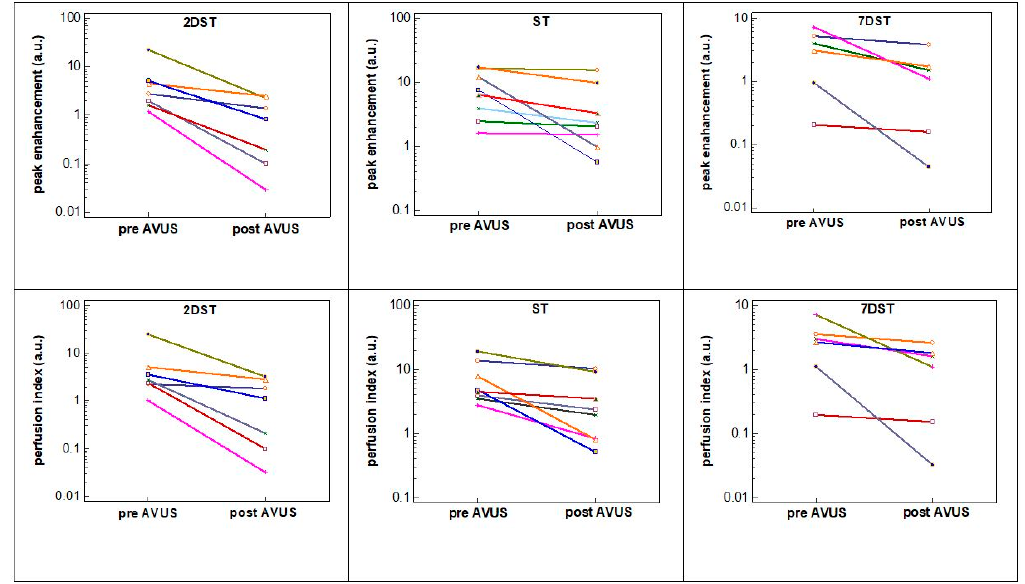
Figure 6. The change in tumor perfusion parameters pre- and post-therapy compared for individual cases in the 2DST, ST and 7DST groups. HCC tumors in the 2DST group showed more uniformity in reduction in tumor perfusion after therapy compared to the other two groups. The x- axis represents the therapy time points (pre- and post-AVUS therapy).